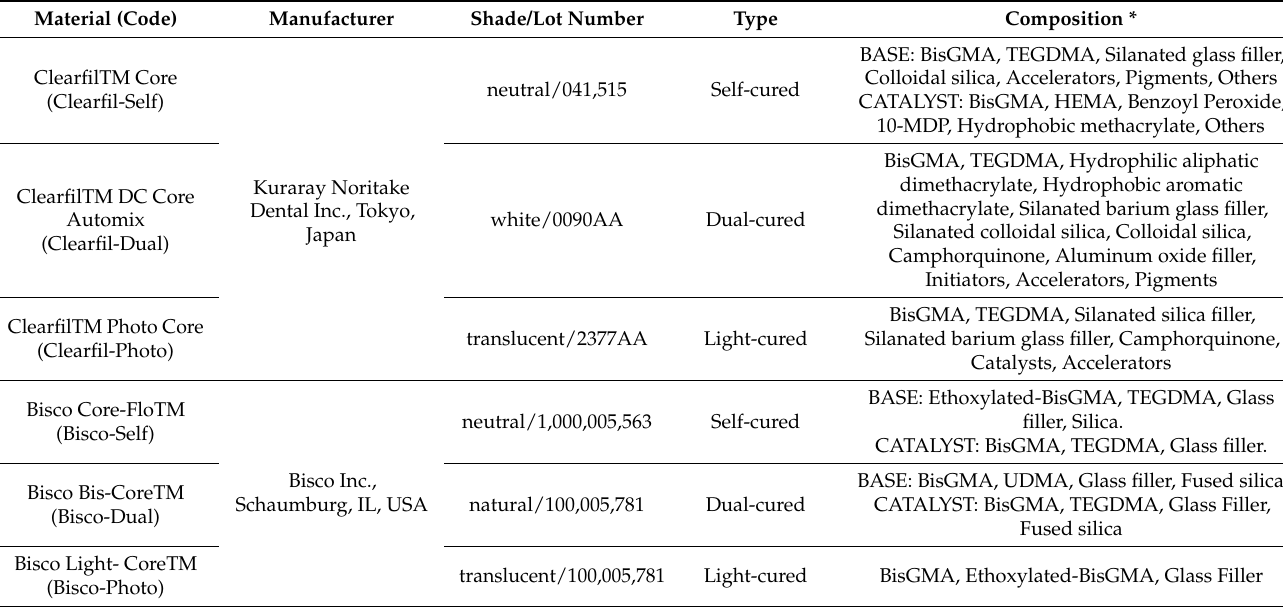
Table 1. Core composites used in this